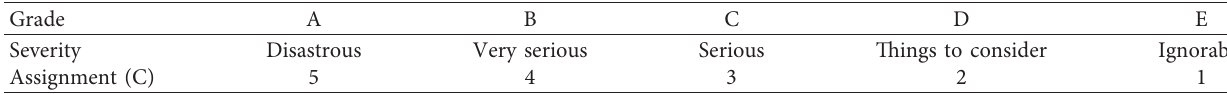
Table 3: The consequence severity grades.